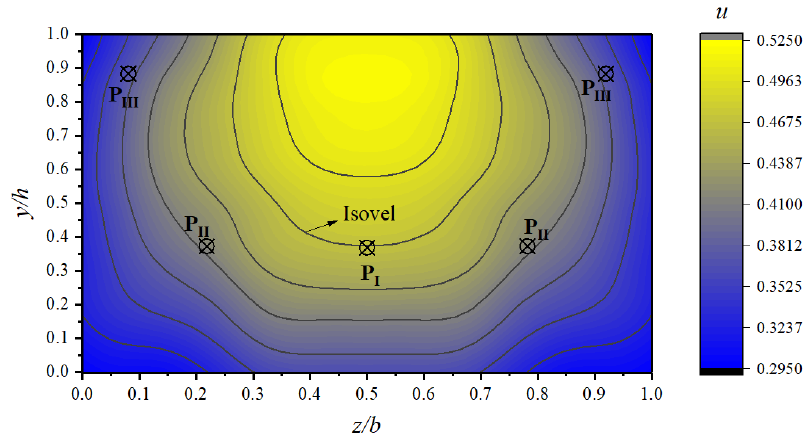
Figure 8. Isovel patterns in a rectangular channel (e.g. R1: b / h = 4.615).